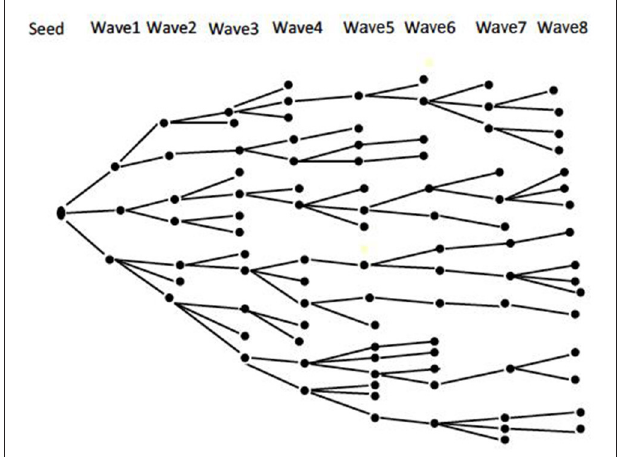
FIGURE 1 | Theoretical RDS recruitment chain [Source—Open Access: Johnston and Sabin,